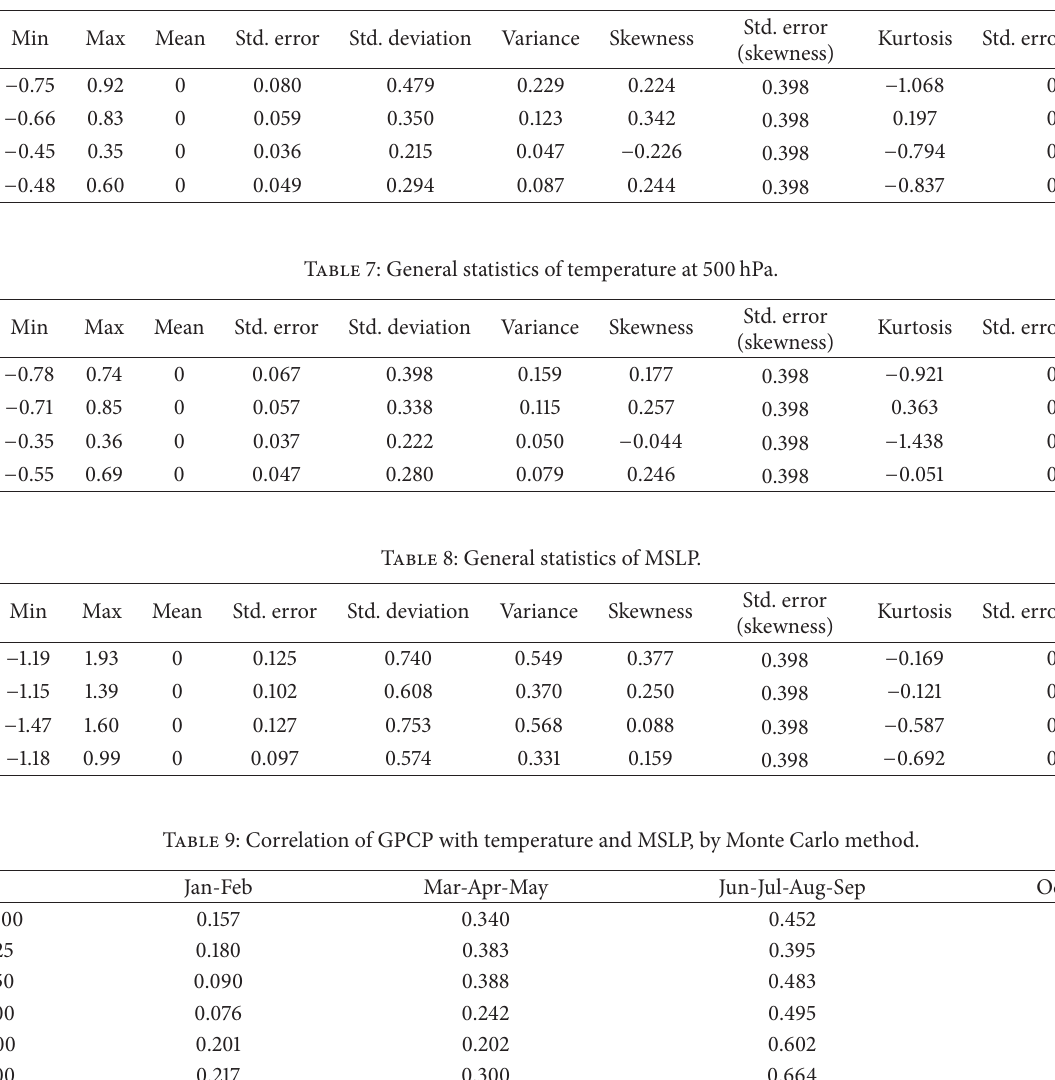
Table 6: General statistics of temperature at 600 hPa.